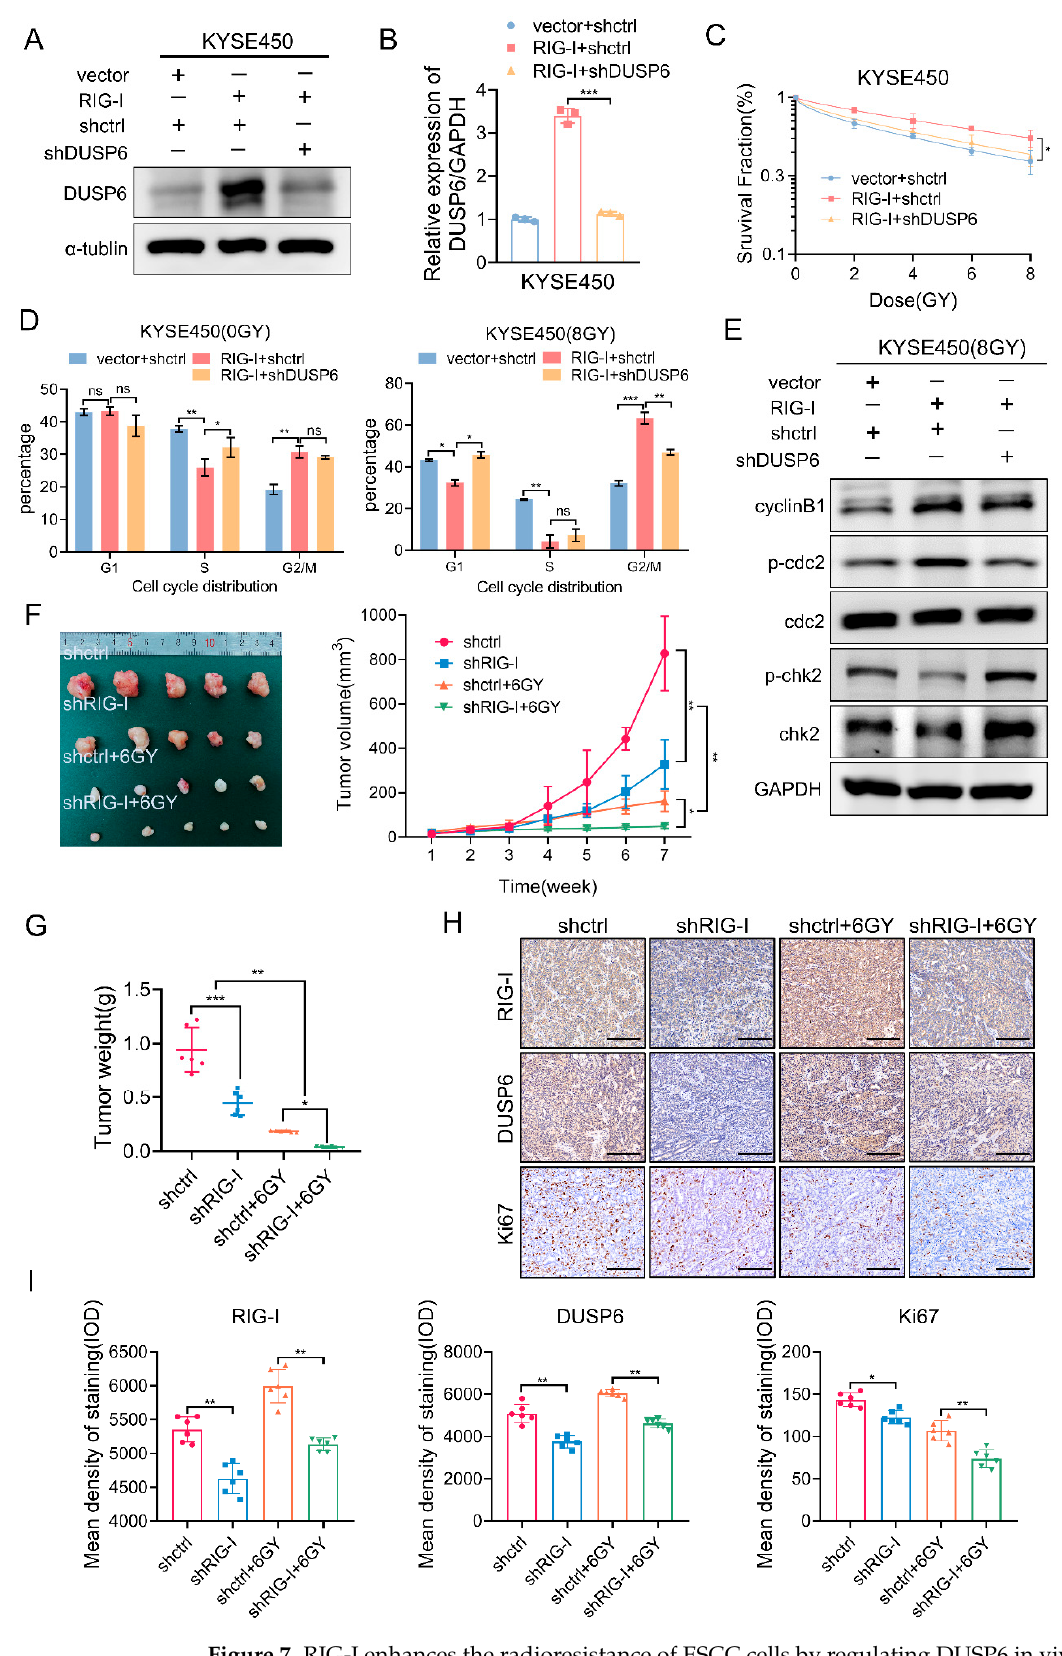
Figure 7. RIG-I enhances the radioresistance of ESCC cells by regulating DUSP6 in vivo or in vitro. Knockdown of DUSP6 in RIG-I overexpressing cells was successfully established. ( A ) DUSP6